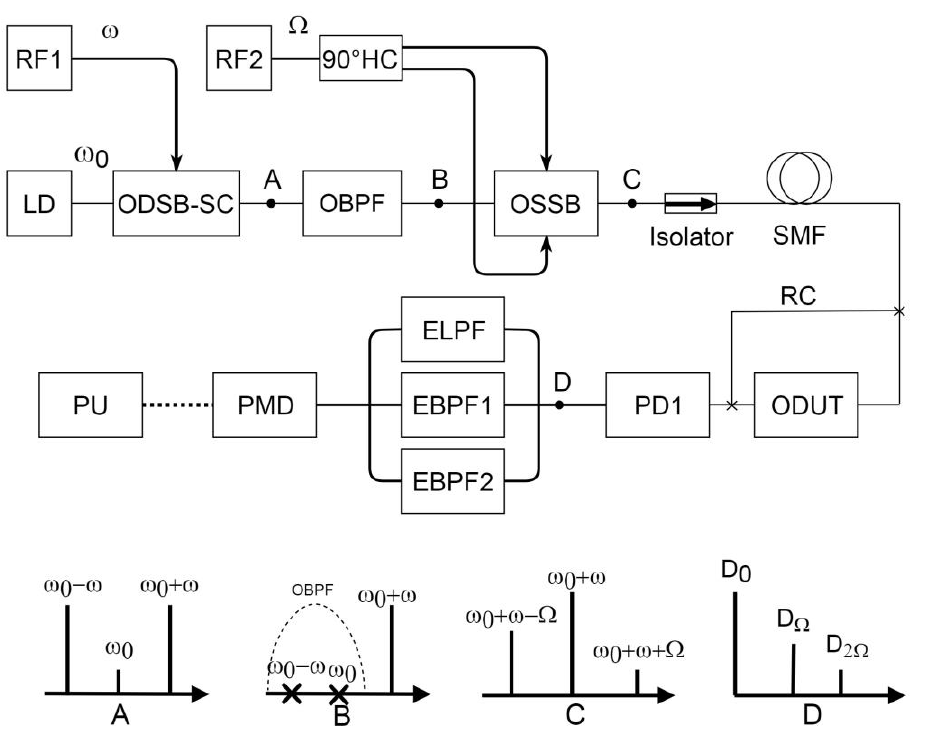
Fig.1 . Block-diagram of the proposed OVA based on UB-ODSB modulation: LD – laser